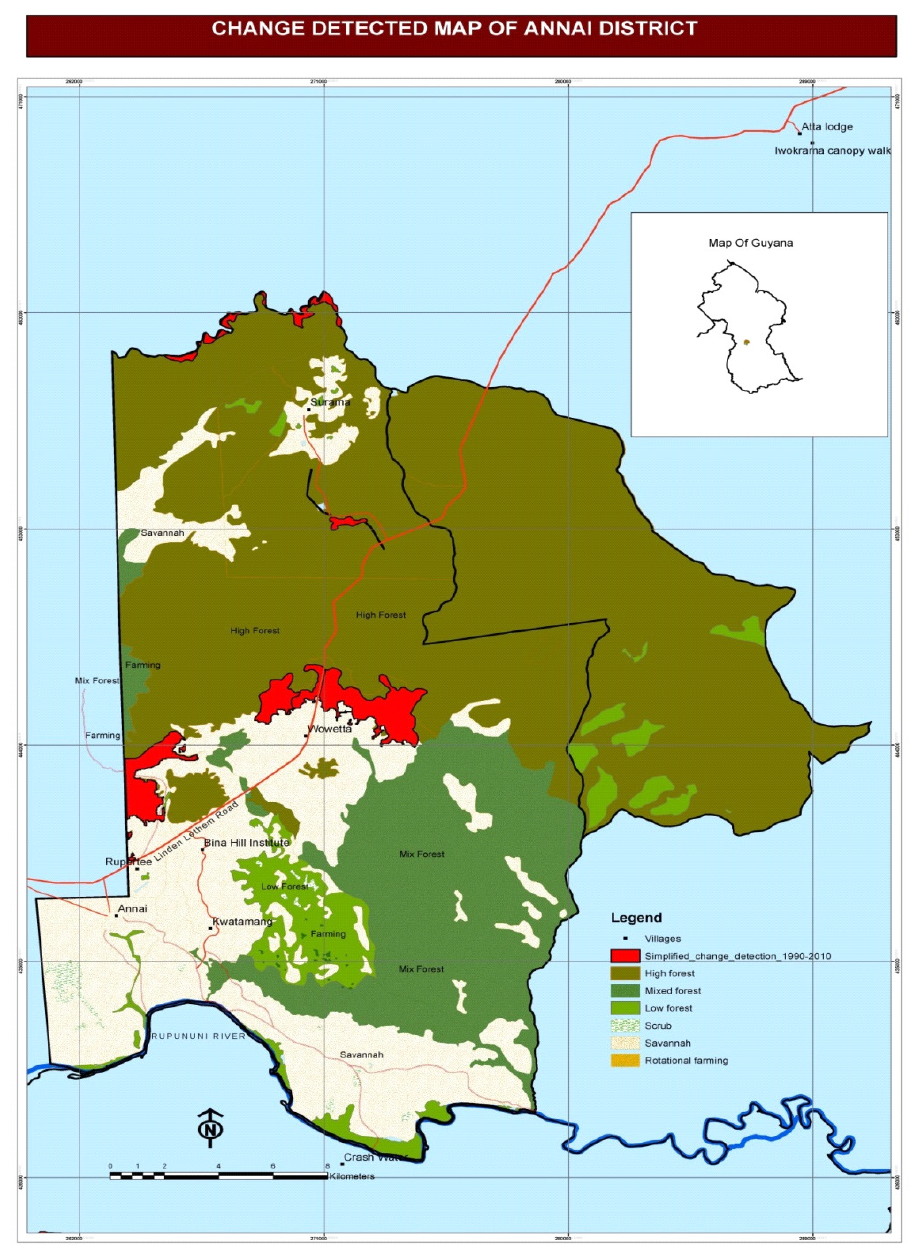
Figure 4. Deforestation areas (red) ground truthed within the Community Demonstration